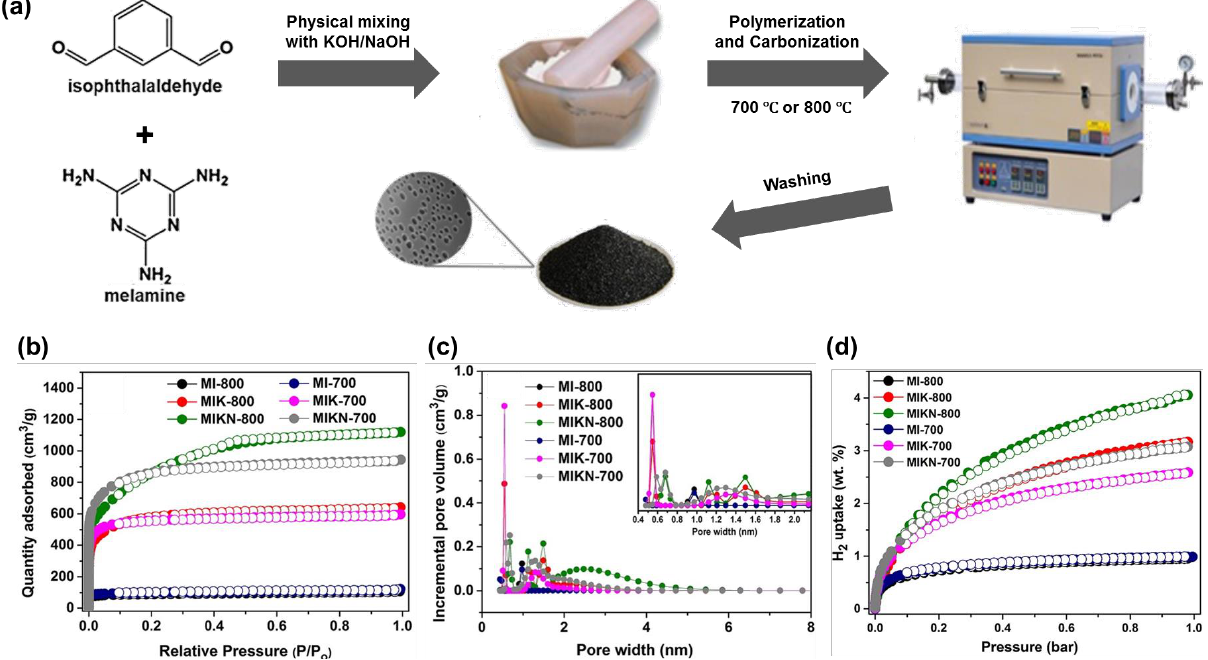
Figure 8. ( a ) Schematic illustration for the one-pot synthesis of microporous carbon derived from melamine and isophthalaldehyde with molten salt as reagents, ( b ) 77 K/N 2 adsorption–desorption isotherms for prepared samples, ( c ) pore size distributions calculated by the NLDFT model, and ( d ) hydrogen uptakes at 77 K and 1 bar. Reproduced from ref. [124]; copyright (2018) with permission from Nature Research.